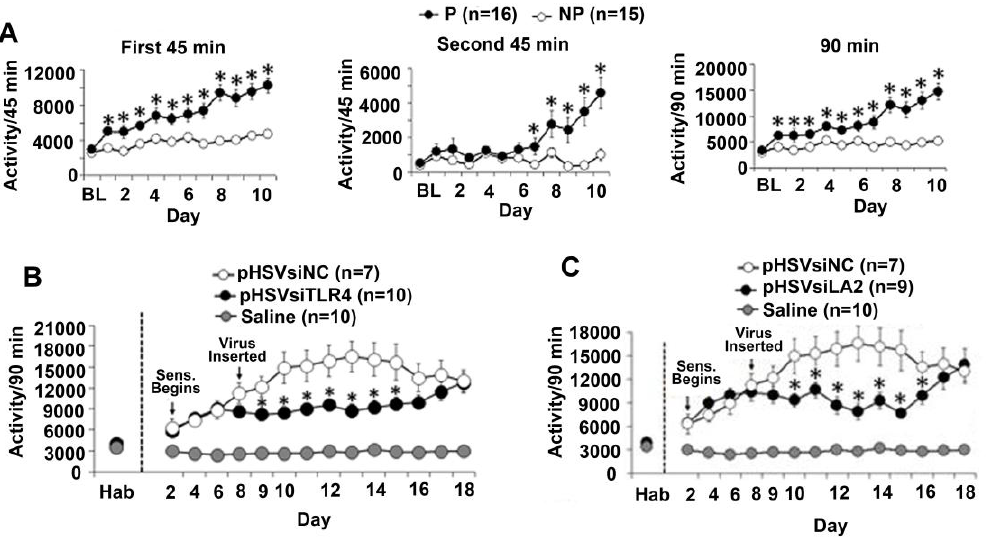
Figure 7. Nicotine enhances locomotor sensitization in the P rats through α2/TLR4. ( A ) Subcutaneous (sc) injections of nicotine (0.4 mg/kg) immediately before the daily locomotor activity examination showed that nicotine sensitization occurs in the P ( n = 16) rats but not in the NP ( n = 15) rats. Compared with the NP rats, the P rats were sensitive to the locomotor-enhancing effects of nicotine, with a significant interaction of Line × Day during the first 45-min ( F (11,154) = 8.723, p <0.001), second 45-min ( F (11,154) = 8.805, p <0.001), and summative 90-min periods ( F (11,154) = 4.047, p <0.001). ( B , C ) The P rats habituated to saline were infused with pHSVsiTLR4 ( n = 10) ( B ), pHSVsiLA2 ( n = 9) ( C ), or pHSVsiNC ( n = 7) ( B , C ) used as a control in the VTA, and after 72 h of recovery, they were given sc injections of nicotine (0.4 mg/kg) and examined for locomotor activity. Saline ( n = 10) was infused alone, and locomotor activity was measured in parallel, with saline infusion showing a baseline of locomotor activity ( B , C ). Horizontal activity of the P rats during nicotine sensitization was significantly decreased by treatment with pHSVsiTLR4 ( B ) or pHSVsiLA2 ( C ) but not pHSVsiNC ( B , C ). Significant Treatment x Day effects were seen following both pHSVsiTLR4 ( F (13, 94) = 3.543, p <0.001) and pHSVsiLA2 ( F (13,89) = 4.232, p <0.001) treatments.